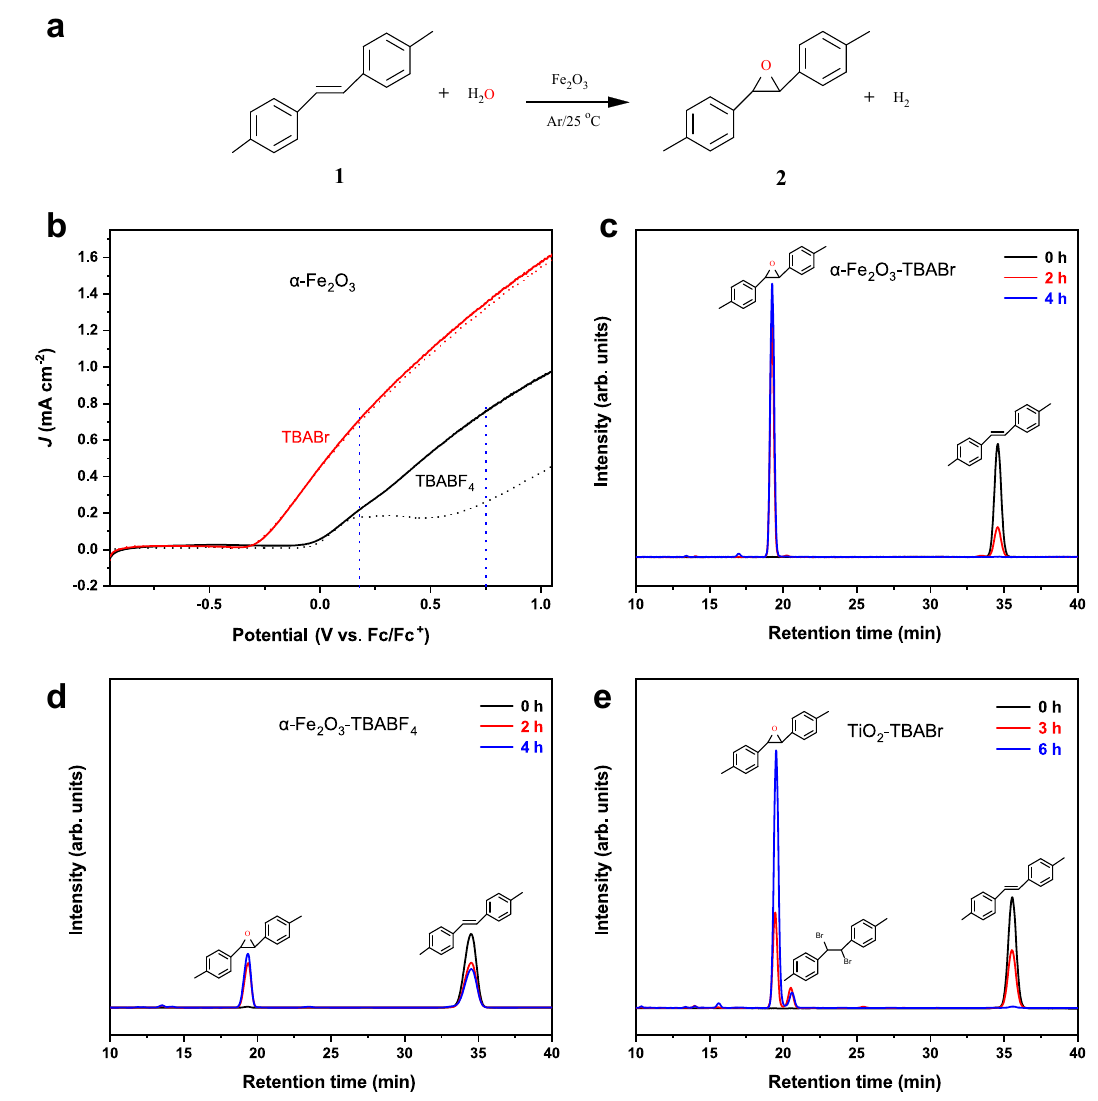
Fig.2|DifferentPECbehaviorsandthecorrespondingliquidchromatogramof epoxide products with different electrolytes and photoanodes. a Reaction equation of Br-mediated epoxidation for substrate 1 . b J – V scan of α -Fe 2 O 3 under AM 1.5G illumination measured in 100mM TBABF 4 (black lines) and TBABr (red lines) solution (CH 3 CN with 5% H 2 O) under an Ar atmosphere without (dash) and with (solid) 10mM 1 . Scan rate 0.05Vs – 1 . The dotted vertical lines indicate the